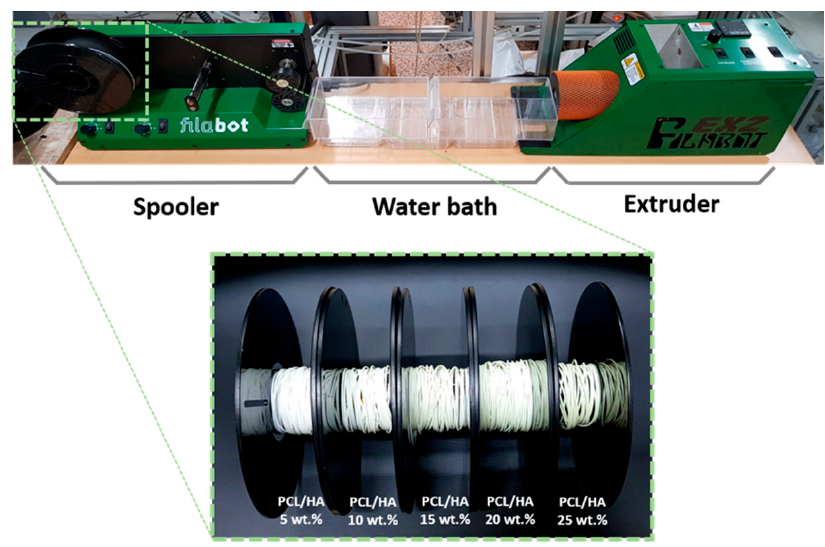
Figure 2. Photographs of Filabot EX2, consisting of spooler, water bath, and extruder ( top ). Fabricated filaments with various HA wt.% produced using the above filament extruder ( bottom ).